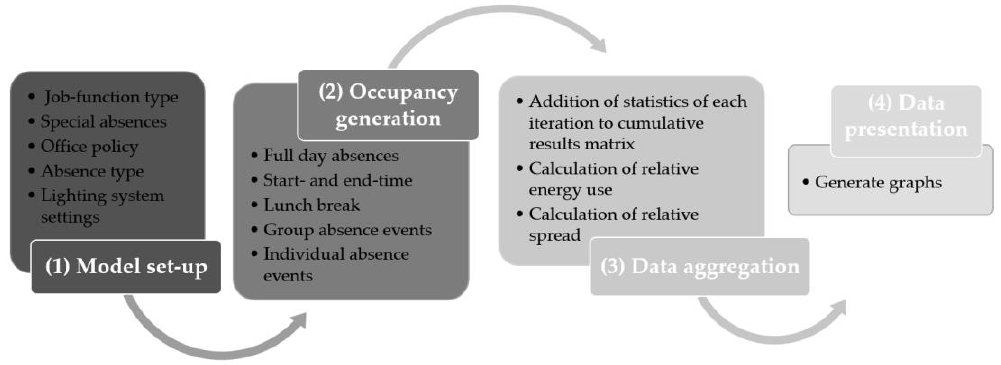
Figure 1. Overview of the steps taken by the simulation model.